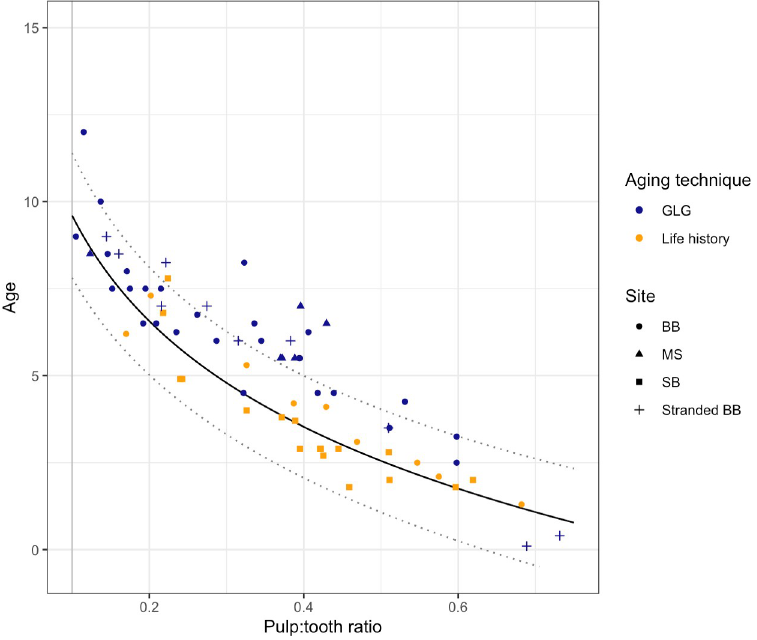
Fig 7. Plot of the linear-log model based on periapical dental radiographs compared to samples with tooth GLG and life history age estimates. Orange points represent the training data set with life history-based age estimates; blue points represent samples without life history information, but with both tooth GLG-based age estimates and periapical dental radiographs. The data set includes both wild, living dolphins (from BB [circles], MS [triangles], and SB [squares]) and dead, stranded dolphins (crosses). The model (black solid line with prediction limits given as dotted lines) consistently predicts lower ages than the GLG-based age estimates (RMSPE = 1.65 years, compared to RMSE = 0.75 for the life history-based age estimates). Data are only shown for samples with a pulp:tooth area ratio � 0.1 (vertical grey line).